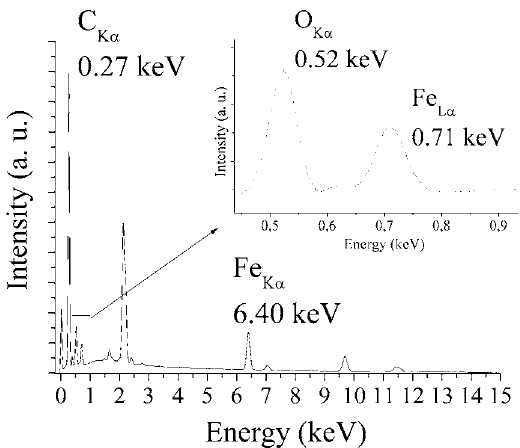
O @C nanoparticles. 3 4